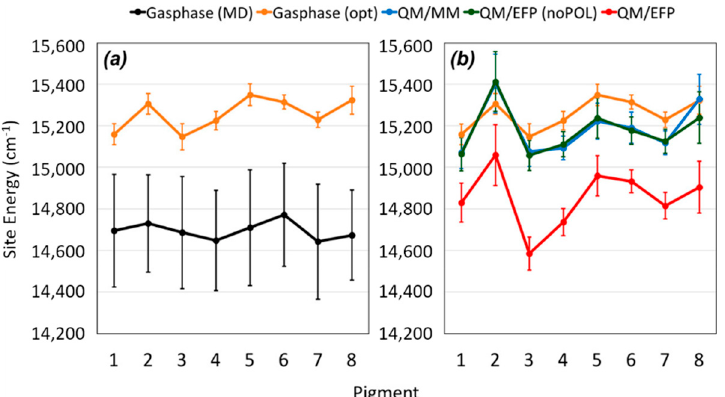
Figure 7. BChl a site energies averaged over 100 structures with standard deviations shown as vertical error bars. ( a ) Gas-phase (without protein environment) site energies computed for structures directly extracted from MD snapshots (black) and after QM/MM geometry optimizations (orange). ( b ) Gas phase (orange), QM/MM (blue), QM/EFP-noPOL (green), and QM/EFP (red) site energies computed for structures after QM/MM geometry optimizations. Reprinted with permission from [74]. Copyright (2020) American Chemical Society.